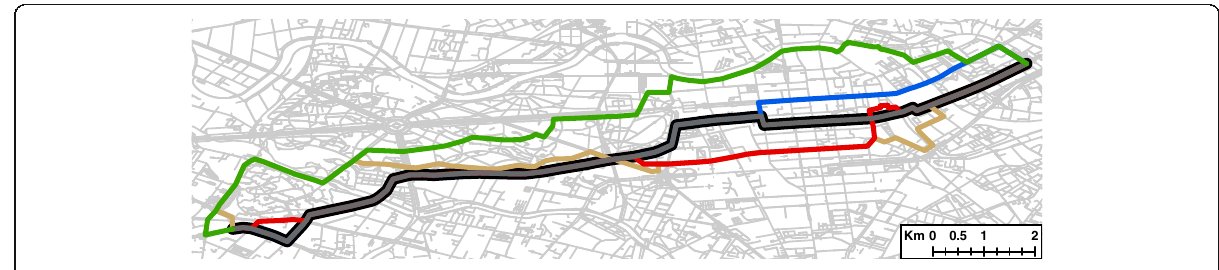
Fig. 13 Inner city routes